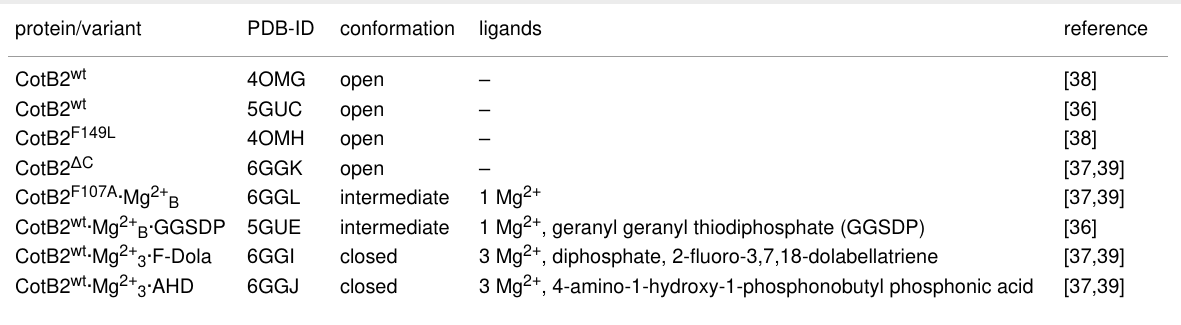
Table 1: Overview of available crystal structures of CotB2 and its variants.